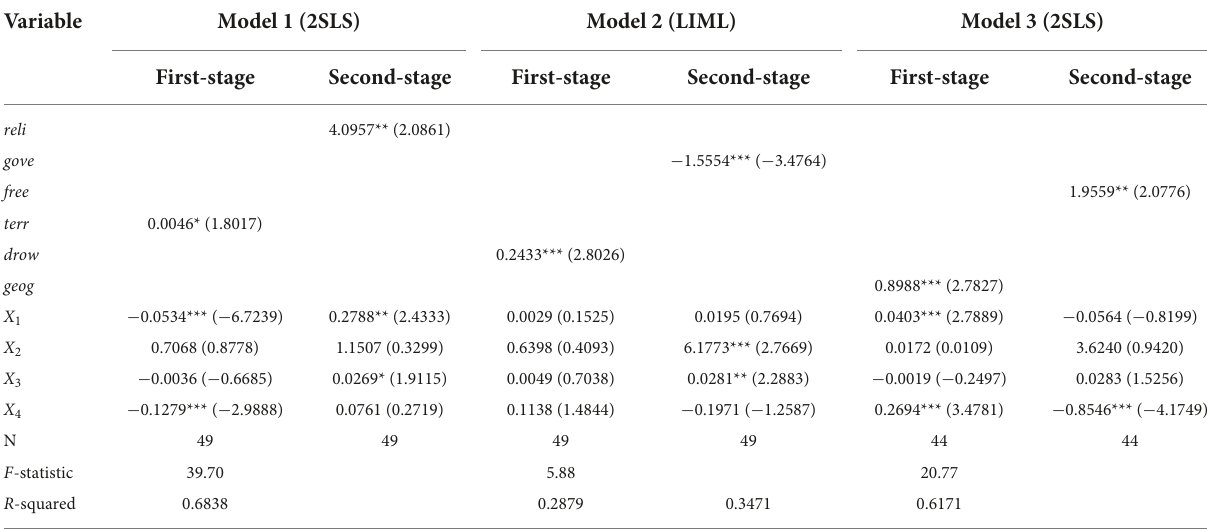
TABLE 4 Regression estimation results for instrumental variables.